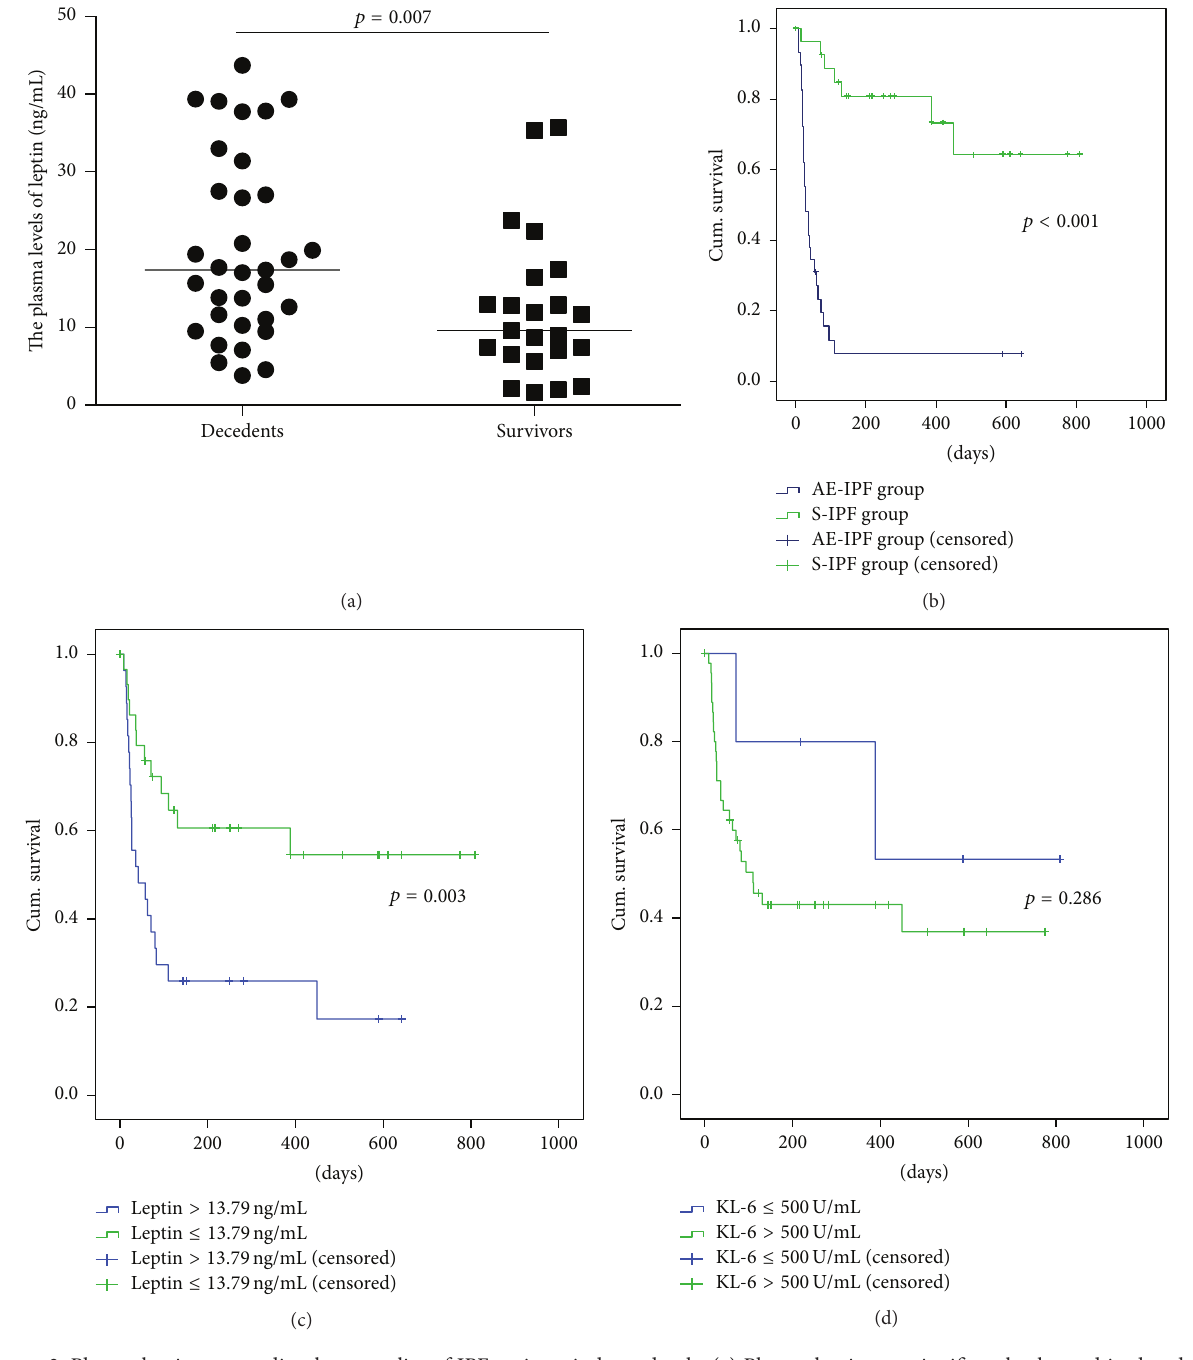
Figure 2: Plasma leptin can predict the mortality of IPF patients independently. (a) Plasma leptin was significantly elevated in decedents ( 𝑛 = 33 ) than that in survivors ( 𝑛 = 23 ) ( 𝑝 = 0.007 ). (b) Kaplan-Meier analyses showed patients with AE-IPF had a significantly higher mortality rate compared with S-IPF subjects by log-rank test ( 𝑝 < 0.001 ). (c) Patients with plasma leptin levels above 13.79 ng/mL had a higher mortality than those with leptin levels lower than that ( 𝑝 = 0.003 ). (d) The survival had no significant difference between